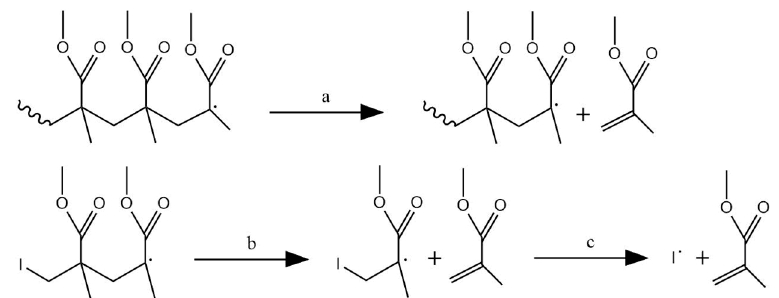
Figure 13. ( a ): Typical end-chain β -scission (“first” type of β -scission) of the tertiary macro-radical formed upon the first or second thermal degradation initiation reaction (see Sections 3.1 and 3.2); ( b ) repetition of the reaction in ( a ) (so-called unzipping) until the initiator fragment I is retrieved ( c ), so case of complete unzipping (here only shows the last two β -scissions) .